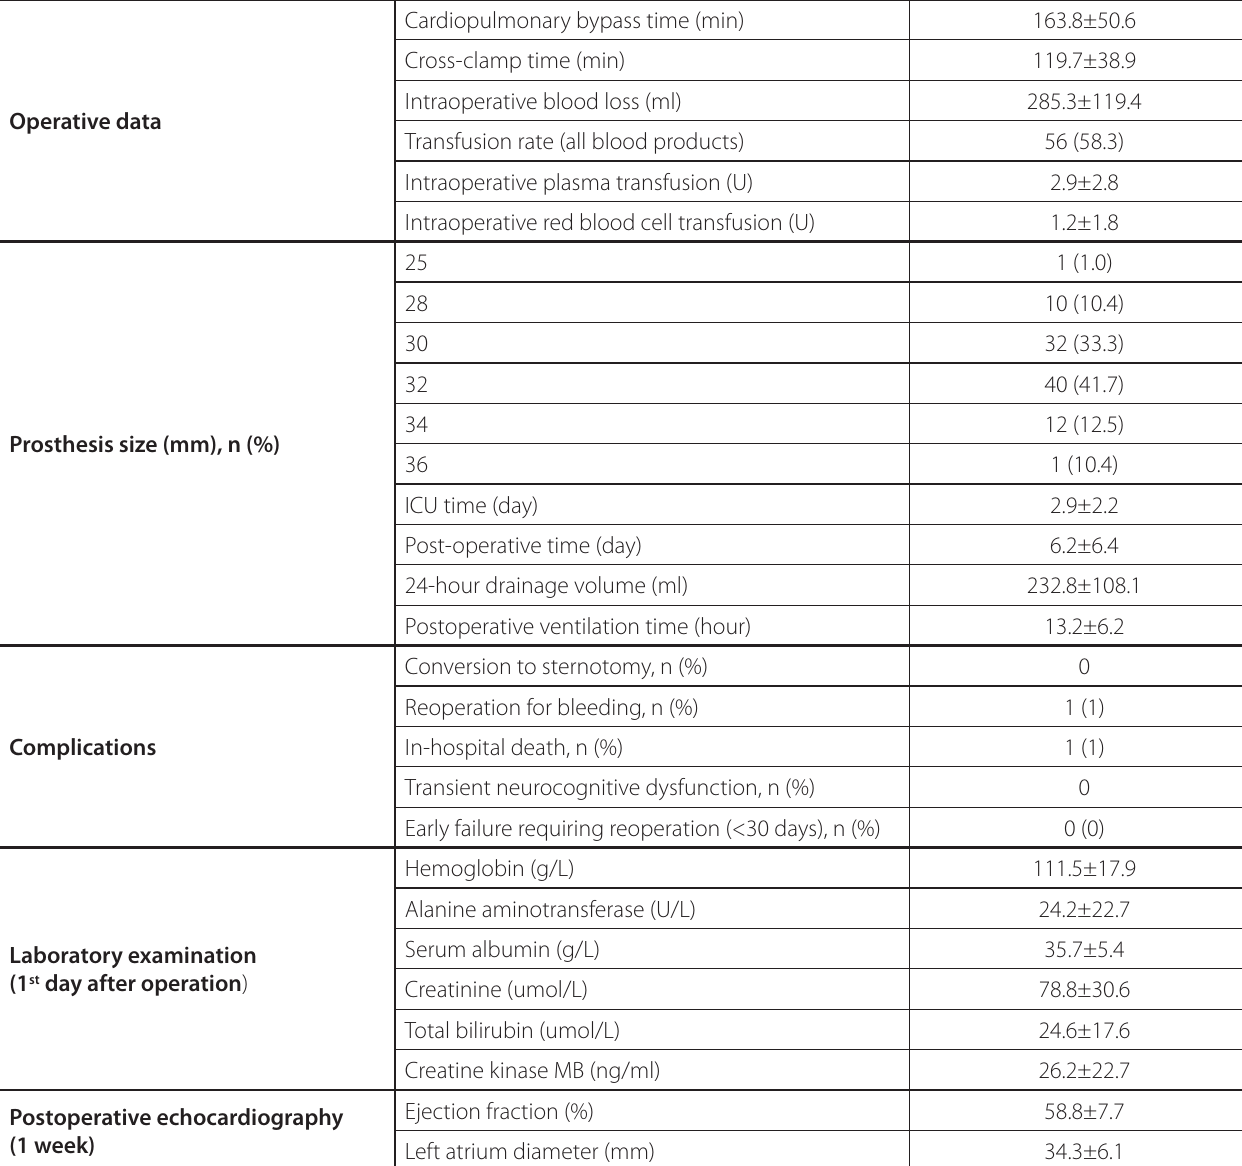
Table 2 . Operative data and clinical outcome.